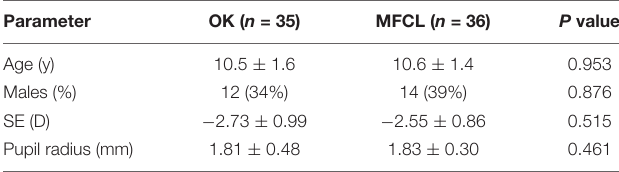
TABLE 1 | Baseline information for subjects.